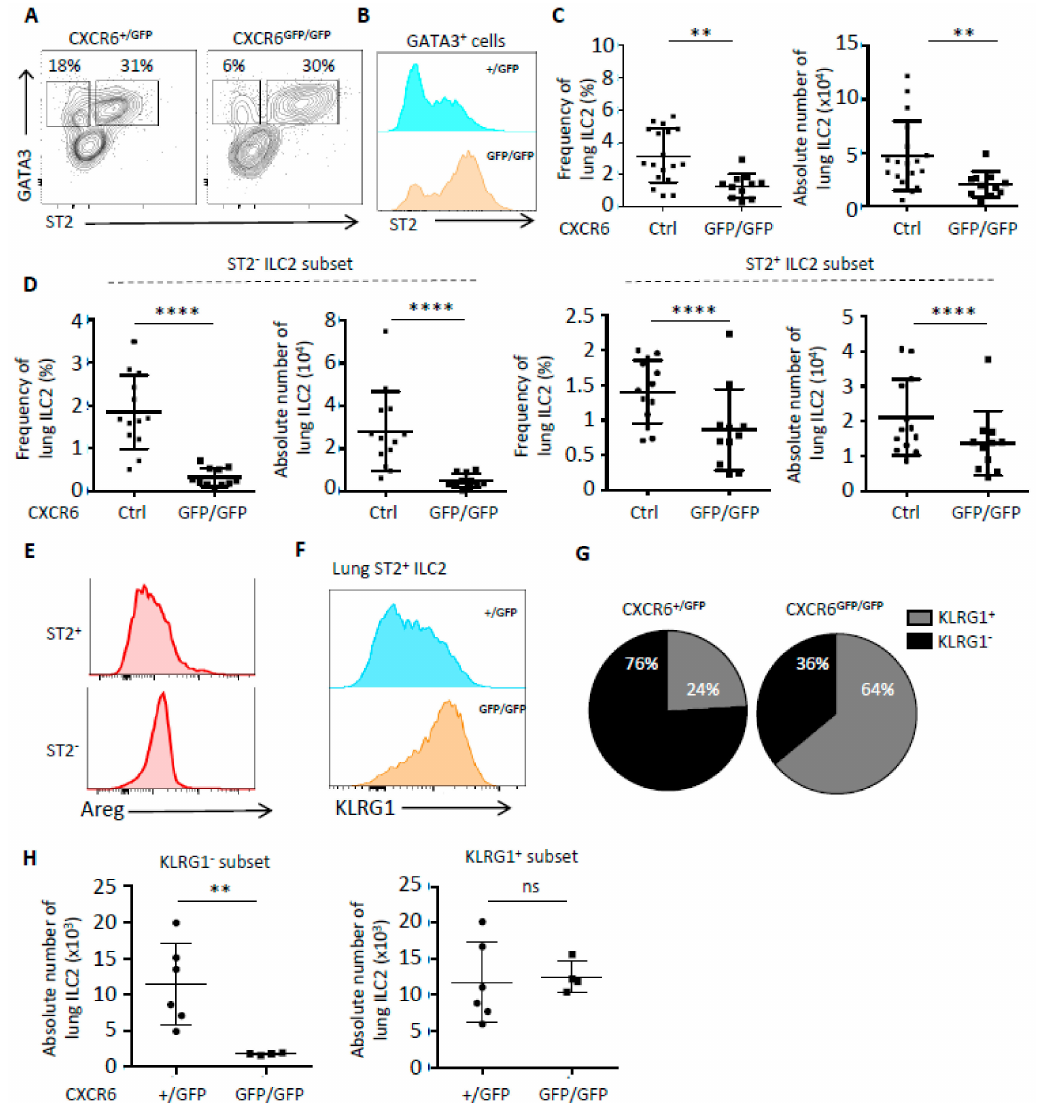
Figure 3. CXCR6 deficiency modifies the phenotype and frequency of ILC2 in an inflammatory context (papain stimulation) ( A ) Flow cytometry analysis of CD45 + Lin − (CD3, CD5, CD19, TCR β , TCR γδ , Gr1, Ter119, CD8 α and F4 / 80) lung cells from Rag − / − CXCR6 +/ GFP and Rag − / − CXCR6 GFP / GFP mice. Di ff erent populations of ILC2 are obtained depending on the ST2 and GATA3 expression. ( +/ GFP = 13, GFP / GFP = 11) ( B ) ST2 MFI of GATA3 + lung cells from Rag − / − CXCR6 +/ GFP and Rag − / − CXCR6 GFP / GFP mice. ( +/+ = 5, +/ GFP = 13, GFP / GFP = 11) ( C ) Frequency and absolute number of lung ILC2 (CD45 + Lin − GATA3 + ) from Rag − / − CXCR6 +/+ and Rag − / − CXCR6 +/ GFP (Ctrl), and Rag − / − CXCR6 GFP / GFP mice. (Ctrl = 18, GFP / GFP = 11) ( D ) Frequency and absolute number of lung ST2 − ILC2 and ST2 + ILC2 (CD45 + Lin − GATA3 + ) from Rag − / − CXCR6 +/+ and Rag − / − CXCR6 +/ GFP (Ctrl), and Rag − / − CXCR6 GFP / GFP mice. (Ctrl = 18, GFP / GFP = 11) ( E ) Flow cytometry analyses of lungST2 + ILC2 (CD45 + CD3 − , NK1.1 − , Sca1 + , CD127 + ) and lung ST2 − ILC2 (CD45 + CD3 − , NK1.1 − , Sca1 + , CD127 + ) from C57Bl6 / J mice for Amphiregulin (Areg) secretion. ( n = 4) ( F ) KLRG1 MFI of GATA3 + ST2 + lung cells from Rag − / − CXCR6 +/ GFP and Rag − / − CXCR6 GFP / GFP mice. ( +/ GFP = 6, GFP / GFP = 4) ( G ) KLRG1 + and KLRG1 − repartition in GATA3 + ST2 + lung cells from Rag − / − CXCR6 +/ GFP and Rag − / − CXCR6 GFP / GFP mice. ( +/ GFP = 6, GFP / GFP = 4) ( H ) Frequency and absolute number of KLRG1 + ST2 + and KLRG1 − ST2 + lung ILC2 (CD45 + Lin − GATA3 + ) from Rag − / − CXCR6 +/ GFP and Rag − / − CXCR6 GFP / GFP mice. ( +/ GFP = 6, GFP / GFP = 4) (** p < 0.01 or **** p <